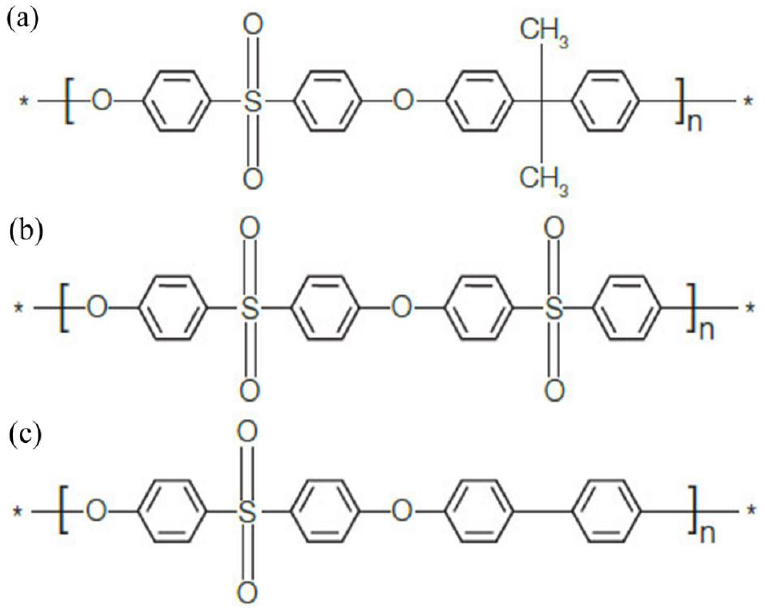
Figure 1. Molecular structures: ( a ) PSf; ( b ) PES; ( c ) PPSU.